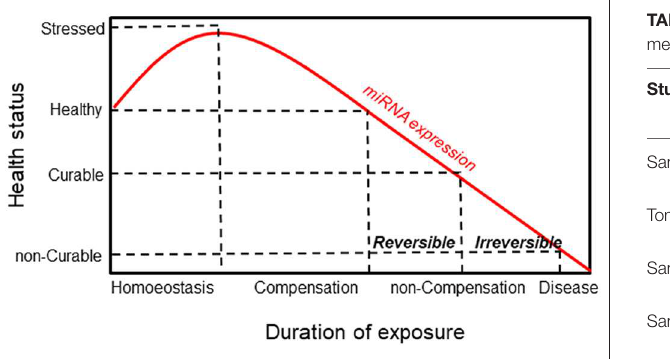
FIGURE 4 | Schematic responses of miRNA and healthy status to environmental exposure. MiRNA expression increases in response to exposure as an adaptive mechanism. This is followed by a compensation phase where miRNA expression is reversible (curable disease). Prolonged exposure induces